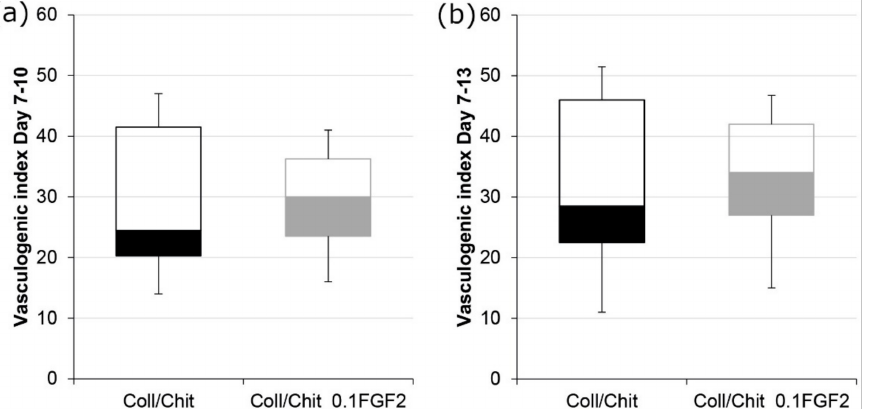
Figure 14. Box plot of vasculogenic index: ( a ) between day 7 and day 10 for Coll/Chit samples without FGF2-STAB ® and with 0.1 µ g/mL of FGF2-STAB ® ; ( b ) between day 7 and day 13 for Coll/Chit samples without FGF2-STAB ® and with 0.1 µ g/mL of FGF2-STAB ®